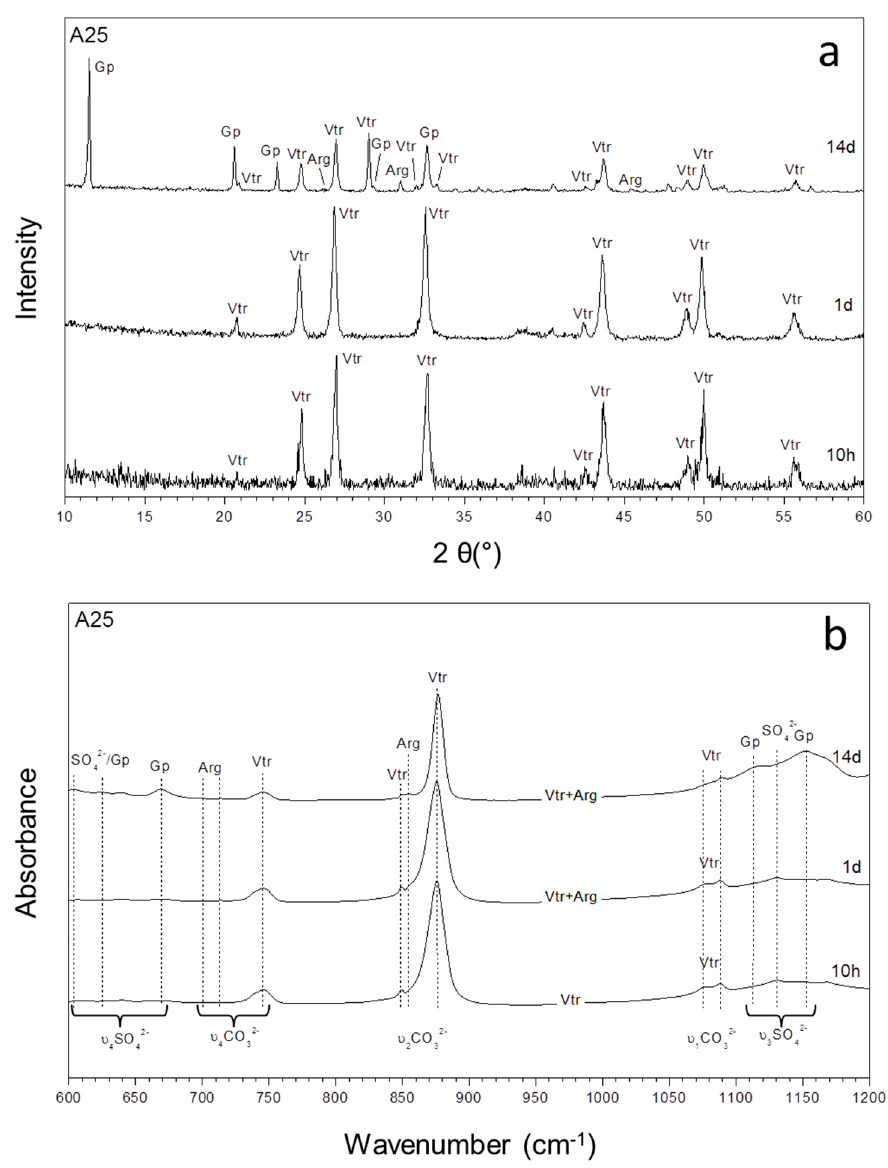
Figure 4. The XRD patterns ( a ) and infrared spectra ( b ) of precipitates sampled from aqueous solutions with the highest (SO 42 − )/(CO 32 − ) ratio (67.6) (A25) as a function of time.